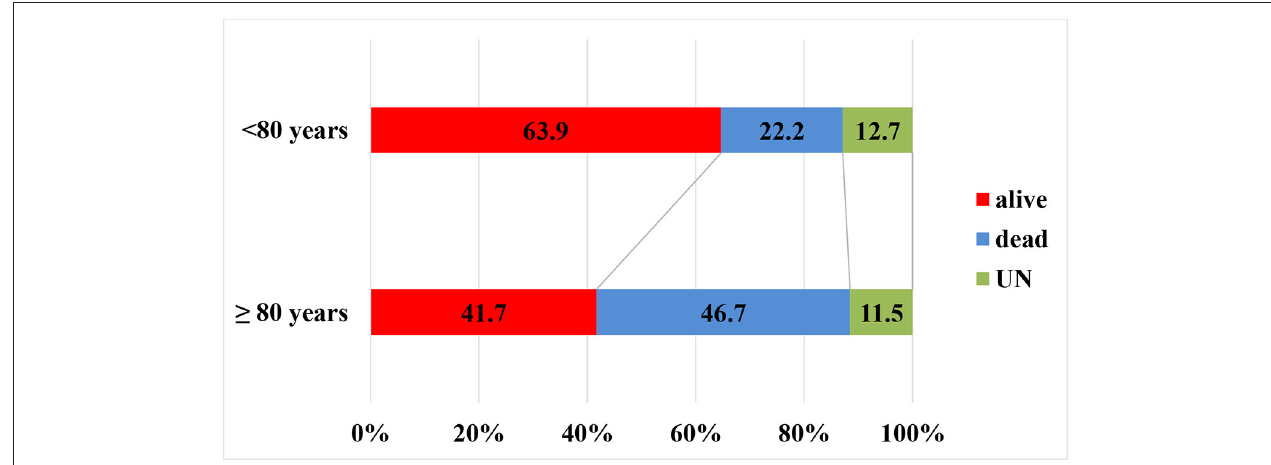
FIGURE 3 | Outcome at 1